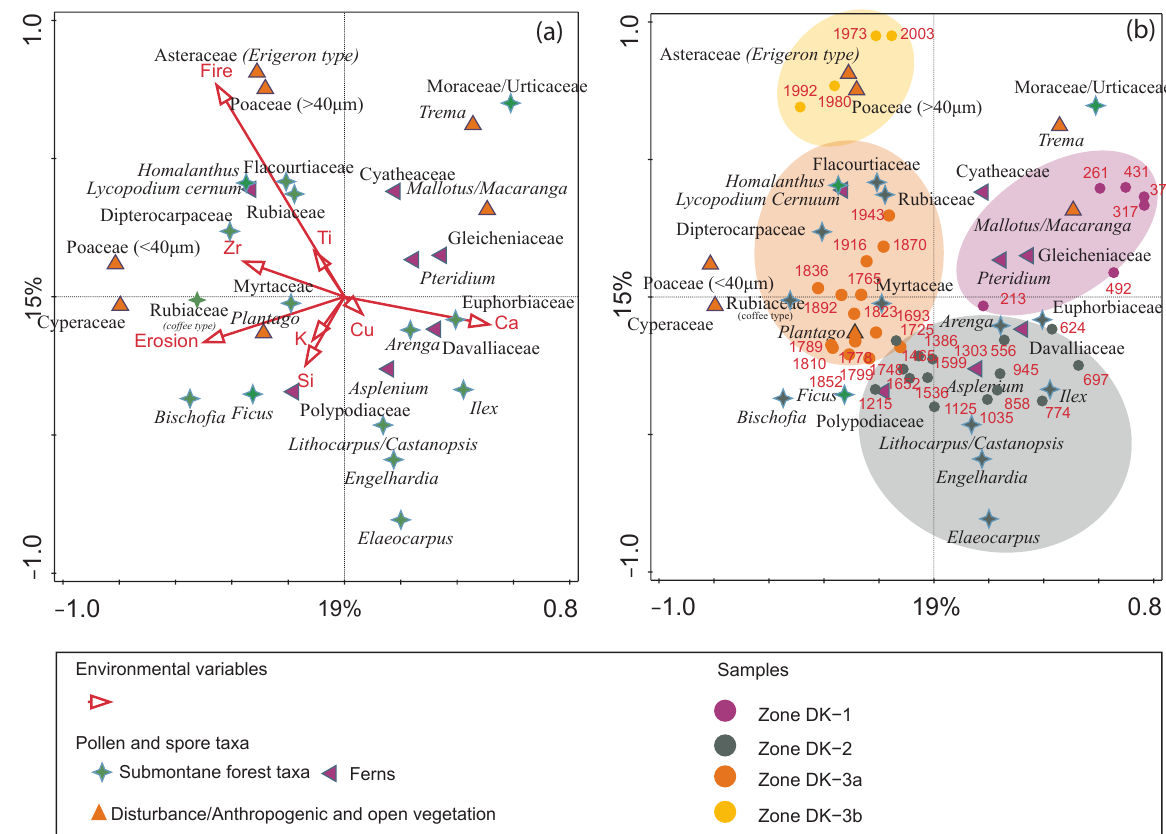
Figure 6. The PCA of the percentage data of identified pollen and spores. Supplementary environ- mental variables were the fire frequency obtained from CharAnalysis, the non-pollen palynomorph ( Glomus ) concentration for erosion, and the lithogenic elements (Ti, Si, K, Cu, Ca, Zr) obtained from the XRF analysis. The first two eigenvalues accounted for 34% of the total variance in composition (PC1: 19%, PC2: 15%). ( a ) Biplots show the representative pollen and spore taxa of each palynological group and the environmental variables driving the vegetation change. ( b ) Biplot species and samples showed a relationship between the sample and pollen and spore taxa of each zonation. Red numbers are the estimated age in AD of each